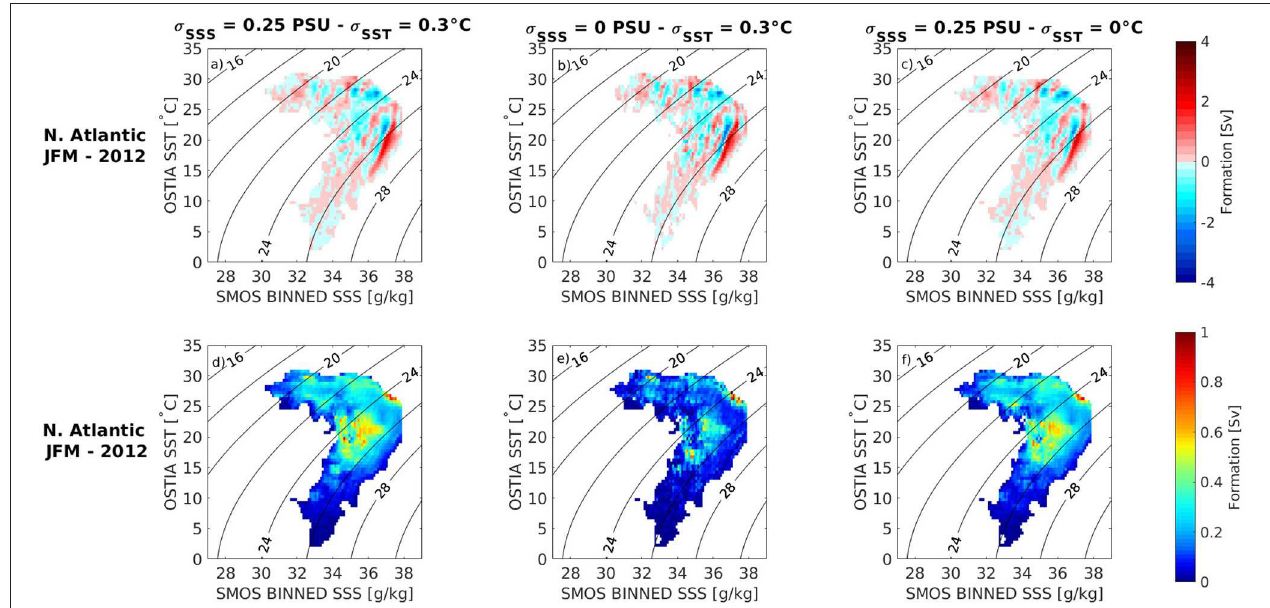
FIGURE 12 | Mean (a–c) and standard deviation (d–f) of formation in θ –S space during the winter months (JFM) in 2012 over the North Atlantic after 500 Monte-Carlo realisations. The Monte-Carlo simulation was run three times with uncertainties considered in both SMOS SSS and OSTIA SST (first column), only OSTIA SST (second column) and only SMOS SSS (last column).